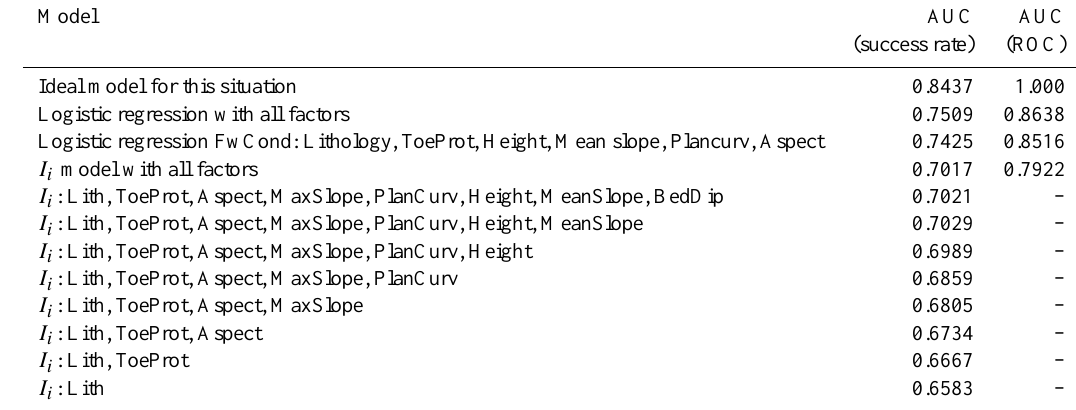
Table 4. Success rate and ROC curves area under the curve (AUC) for the different models. Model Ideal model for this situation Logistic regression with all factors